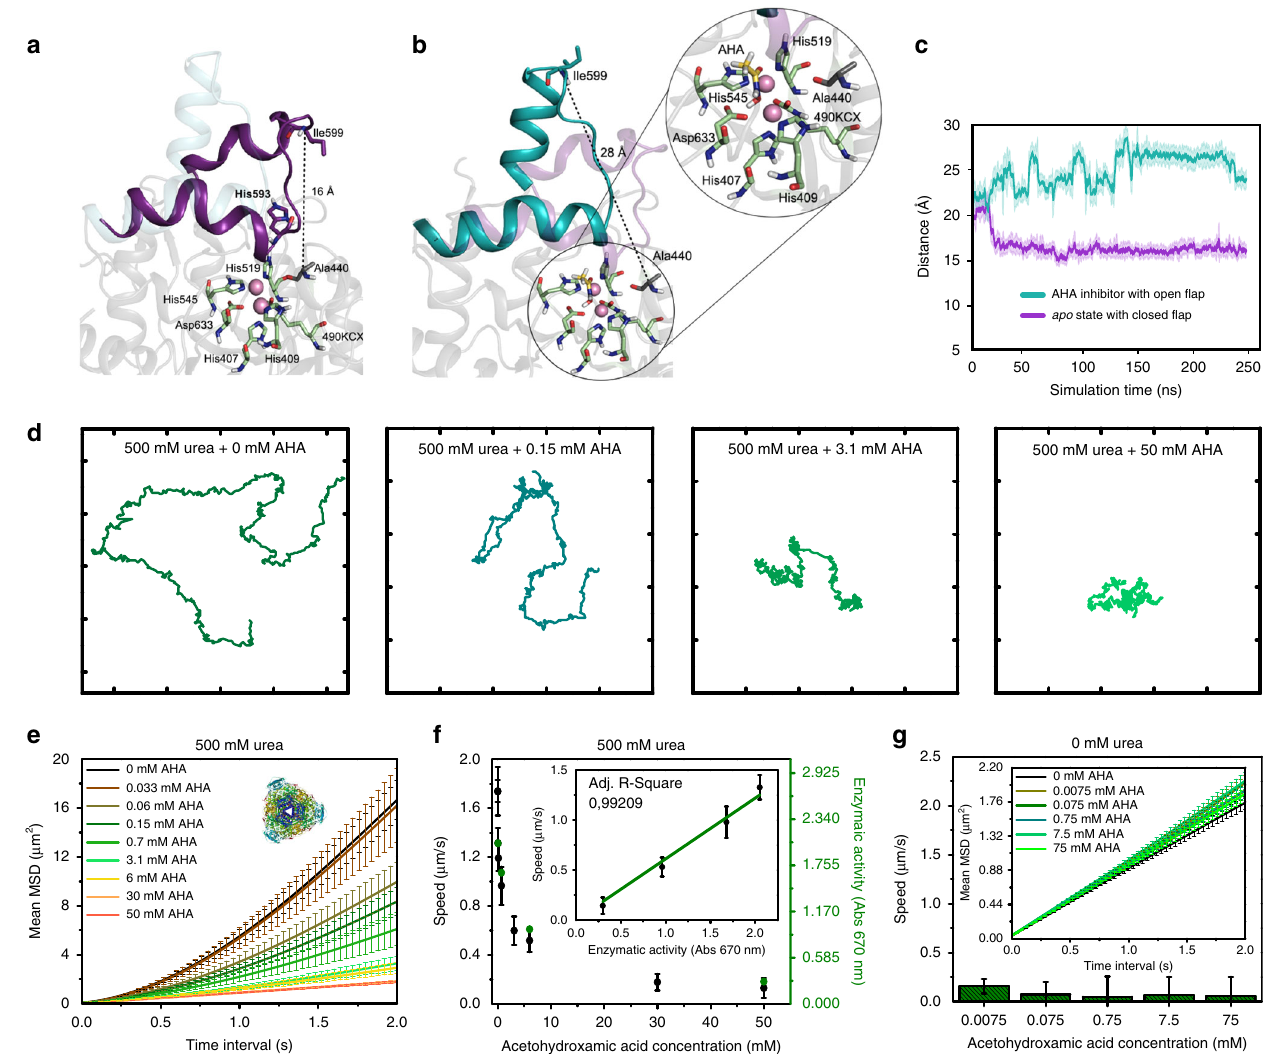
Fig. 5 Conformation of UR and motion behavior of UR-HSMM exposed to AHA. Representative snapshots from MD simulations of a UR in apo state where the fl ap covering the active site can adopt a closed conformation (purple) and b AHA, which stabilizes wide-open conformations of the fl ap (teal). The zoom of the active site residues shows catalytic residues in green, nickel atoms in pink, and the AHA inhibitor in yellow. c MD simulated fl ap distance between Ala440 – Ile599 in the apo state (purple) and AHA-bound state (teal). Results are shown as the mean ± standard deviation (s.d.). d Representative 28-s trajectories of UR-HSMM exposed to 500 mM urea and different concentrations of AHA (axis divided into 5 µ m fragments). e Average MSD of UR- HSMM exposed to AHA with urea present in excess (500 mM). Enzyme structures are extracted from RCSB PDB (see Supplementary Note 3). f Average speed of UR-HSMM, extracted from the MSD analysis, and enzymatic activity for different AHA concentrations with urea present in excess (500 mM). Inset: correlation between speed of UR-HSMM and its enzymatic activity depending on inhibition. g Average speeds of UR-HSMM for different concentrations of AHA. Inset: average MSD of UR-HSMM exposed to AHA. Results are shown as the mean ± s.e.m. Twenty particles were analyzed per condition. Source data are provided as a Source Data fi